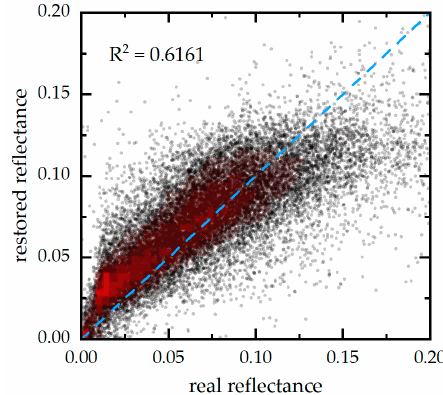
Figure 7. The scatterplot of the restored reflectance versus the real reflectance of the 90,000 snow cover samples in the SWIR band.